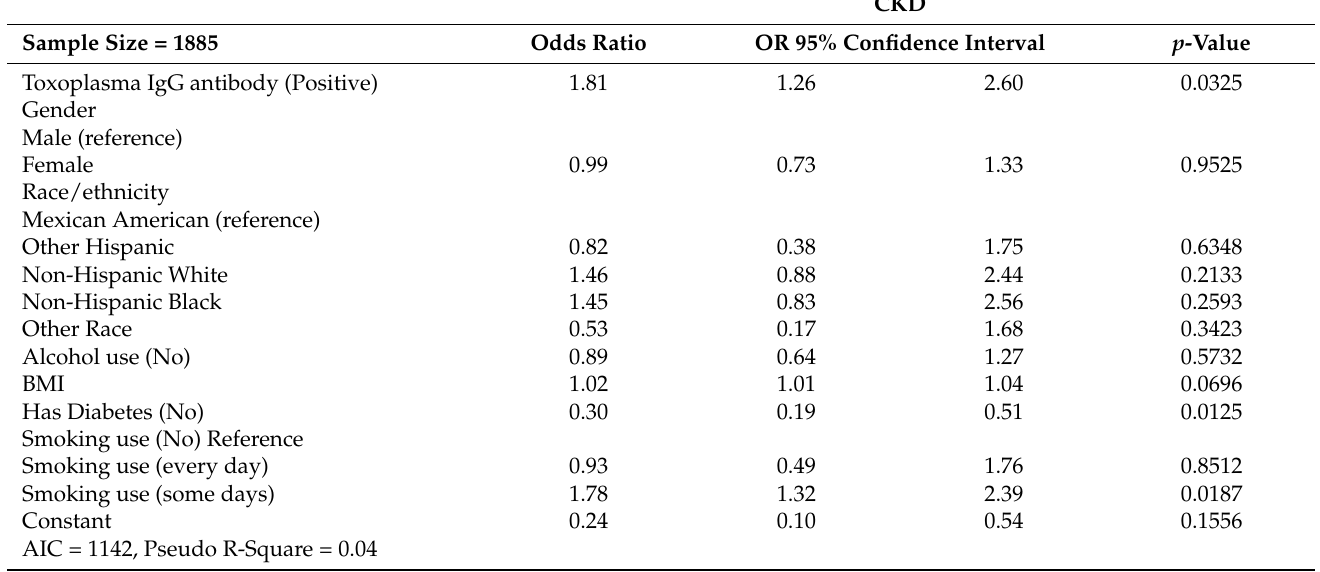
Table 7. Binomial Logistic regression model for CKD status on T. gondii IgG antibody (posi- tive/negative) adjusted for the demographic factors (except age) and other covariates, including